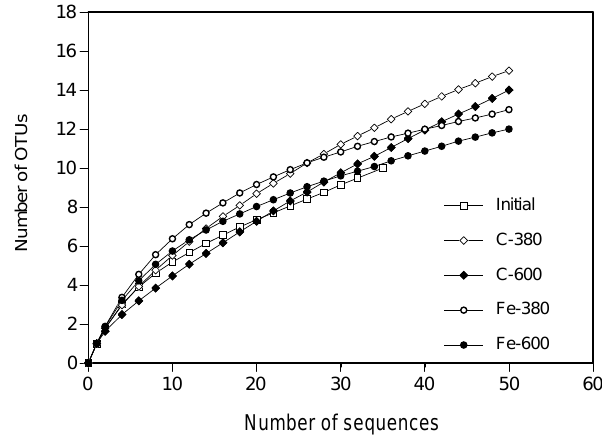
Figure 5. Rarefaction analysis of the diatom-specific rbcL clone li- braries. The rarefaction curves, plotting the number of operational taxonomic units (OTUs) as a function of the number of sequences, were computed by the software mothur. C and Fe indicate the con- trol and Fe-added treatments,